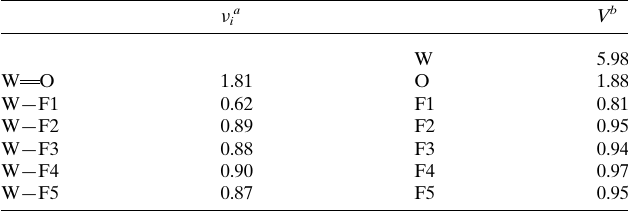
Table 1 Bond valences and sums of the [WOF 5 ] (cid:2) anion in (1,10-phen-H)[WOF 5 ].